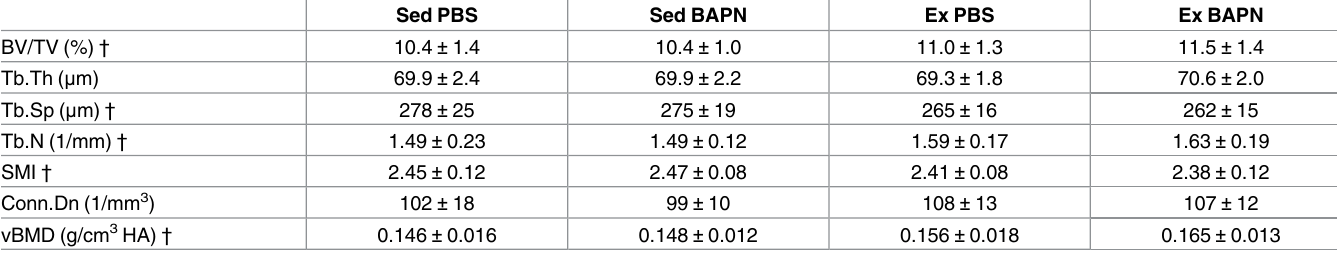
Table 5. Trabecular analysis of distal femora.